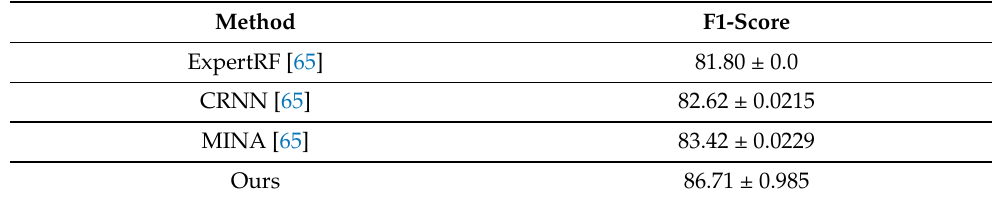
Table 7. Comparative results for atrial fibrillation (AF) anomaly